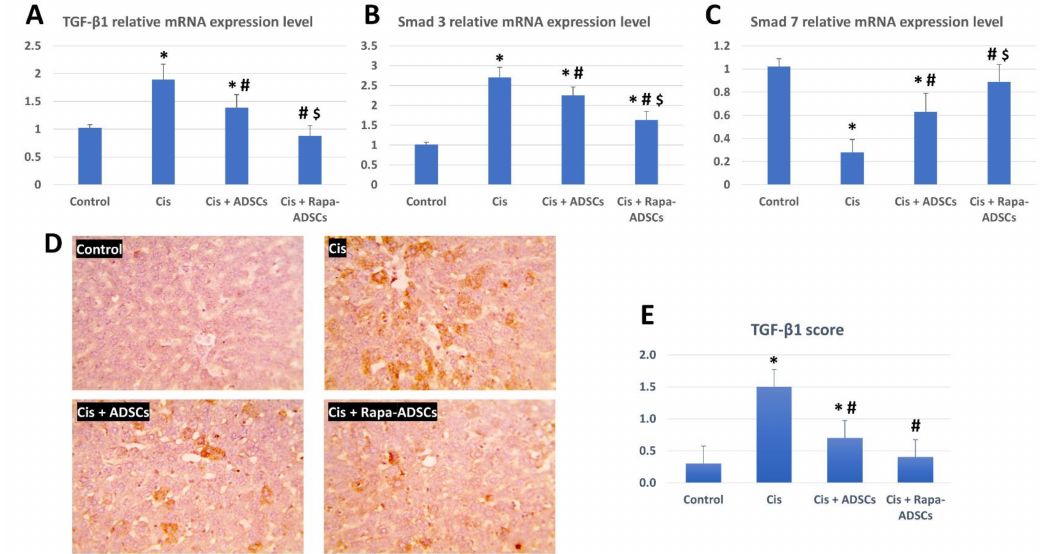
Figure 6. The effects of administering rapamycin-preconditioned ADSCs on liver TGF- β 1/Smad signaling pathway in cisplatin (Cis)-induced liver damage. ( A ) TGF- β 1 relative mRNA expression in the study groups. ( B ) Smad3 relative mRNA expression in the study groups. ( C ) Smad7 relative mRNA expression in the study groups. ( D ) Immunohistochemical staining of TGF- β 1 in the liver tissue in the different groups, magnification 400 × . ( E ) TGF- β 1 score from the images in ( D ) from the different studied groups. Cis, cisplatin (i.p. injection of 5 mg/kg in 0.9% saline) group; Cis + ADSCs, cisplatin group receiving ADSCs (one million cells, intravenous in tail vein); Cis + Rapa-ADSCs, cisplatin group receiving same number of ADSCs preconditioned with rapamycin (50 nM/L, 2 h prior to administration). Statistical significance, * vs. control group ( p < 0.01), # vs. Cis group ( p < 0.01) and $ vs. Cis+ADSCs group ( p < 0.05).